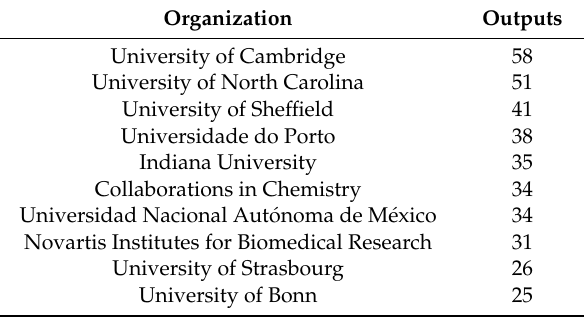
Table 3. Organizations producing the largest numbers of chemoinformatics outputs.